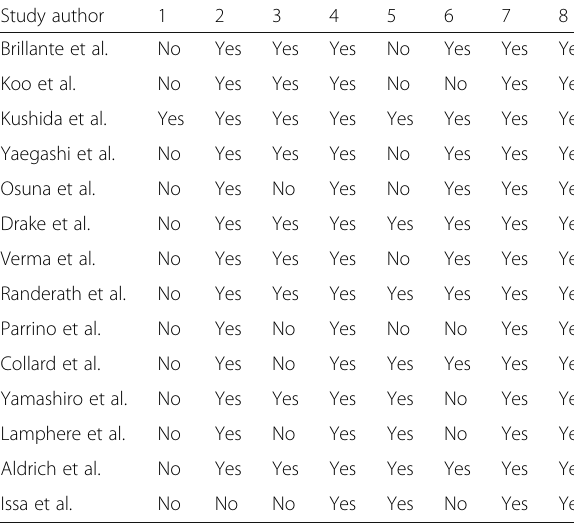
Table 4 Assessment of *quality of studies included in